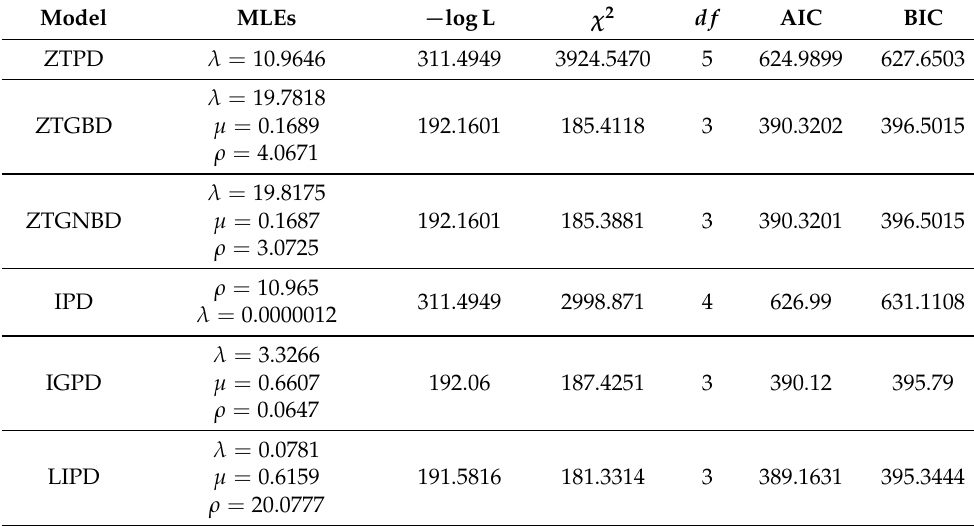
Table 5. MLEs and GOF values for the student enrollment